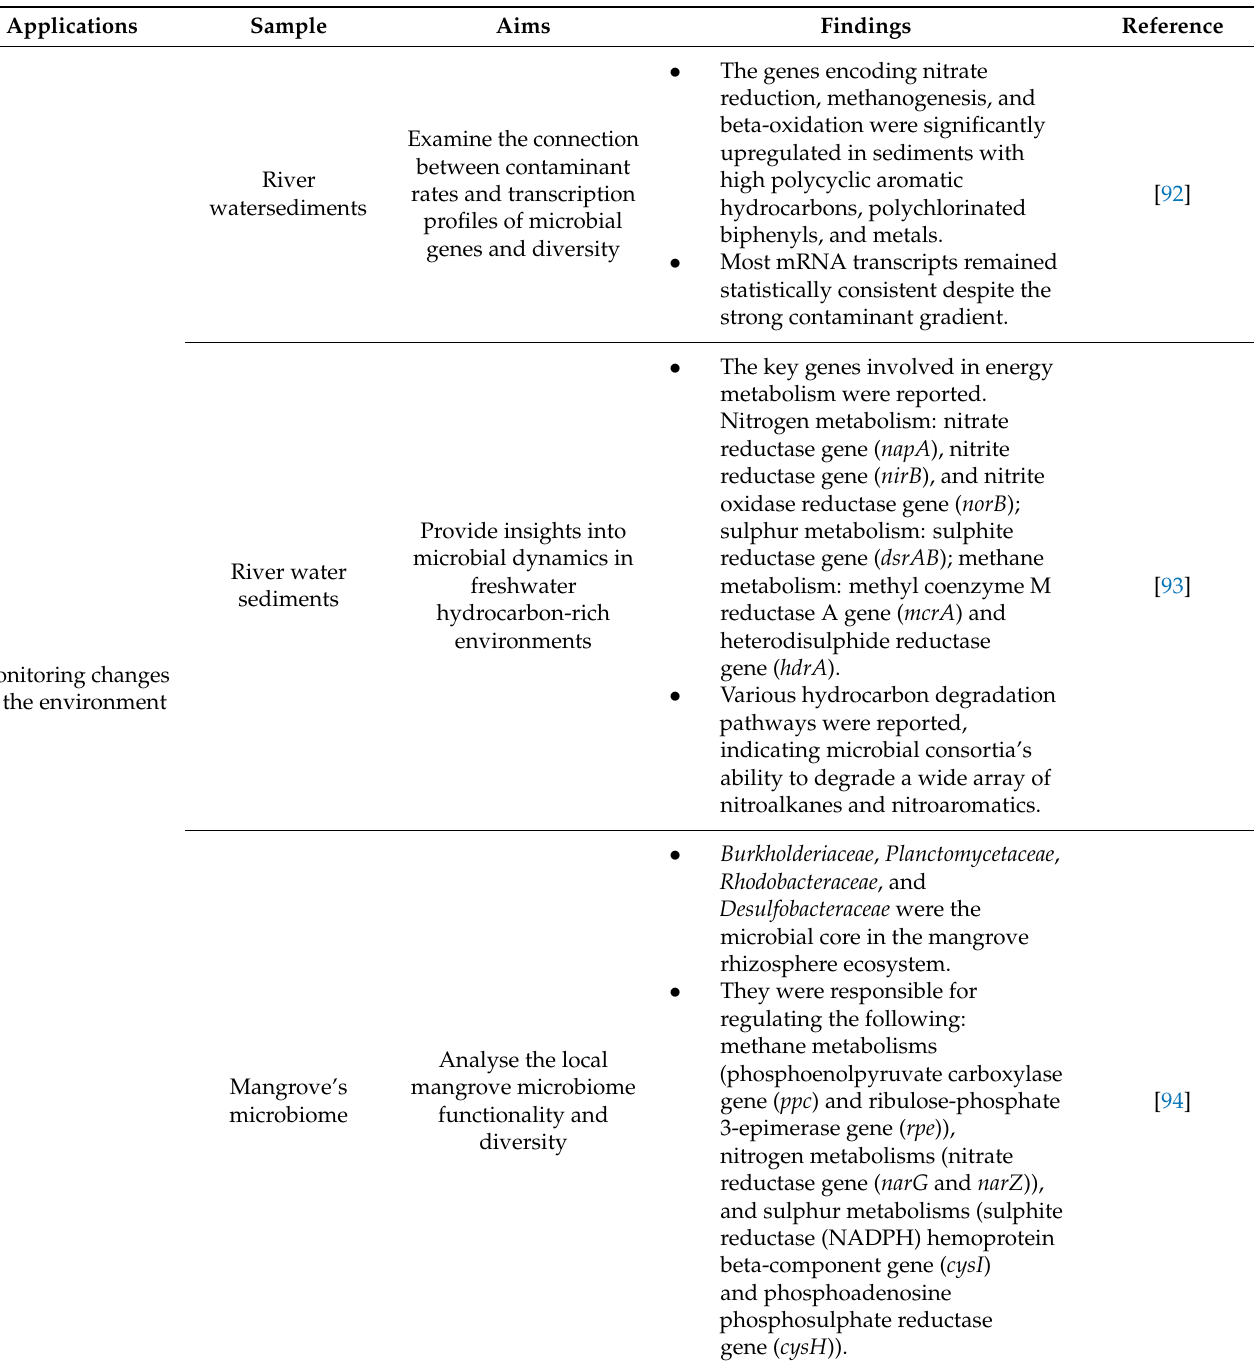
Table 2. The application of metatranscriptomics in sustaining environmental health, contributing to SDGs 6 and